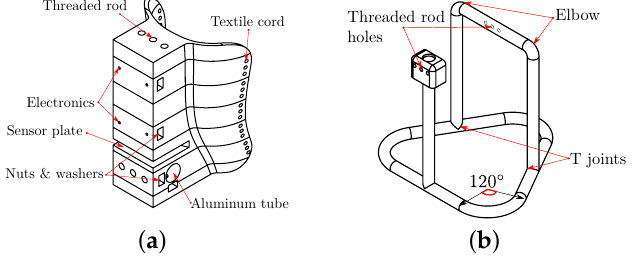
Figure 17. Mechanical attachment: ( a ) calf support and ( b ) aluminum tube structure.